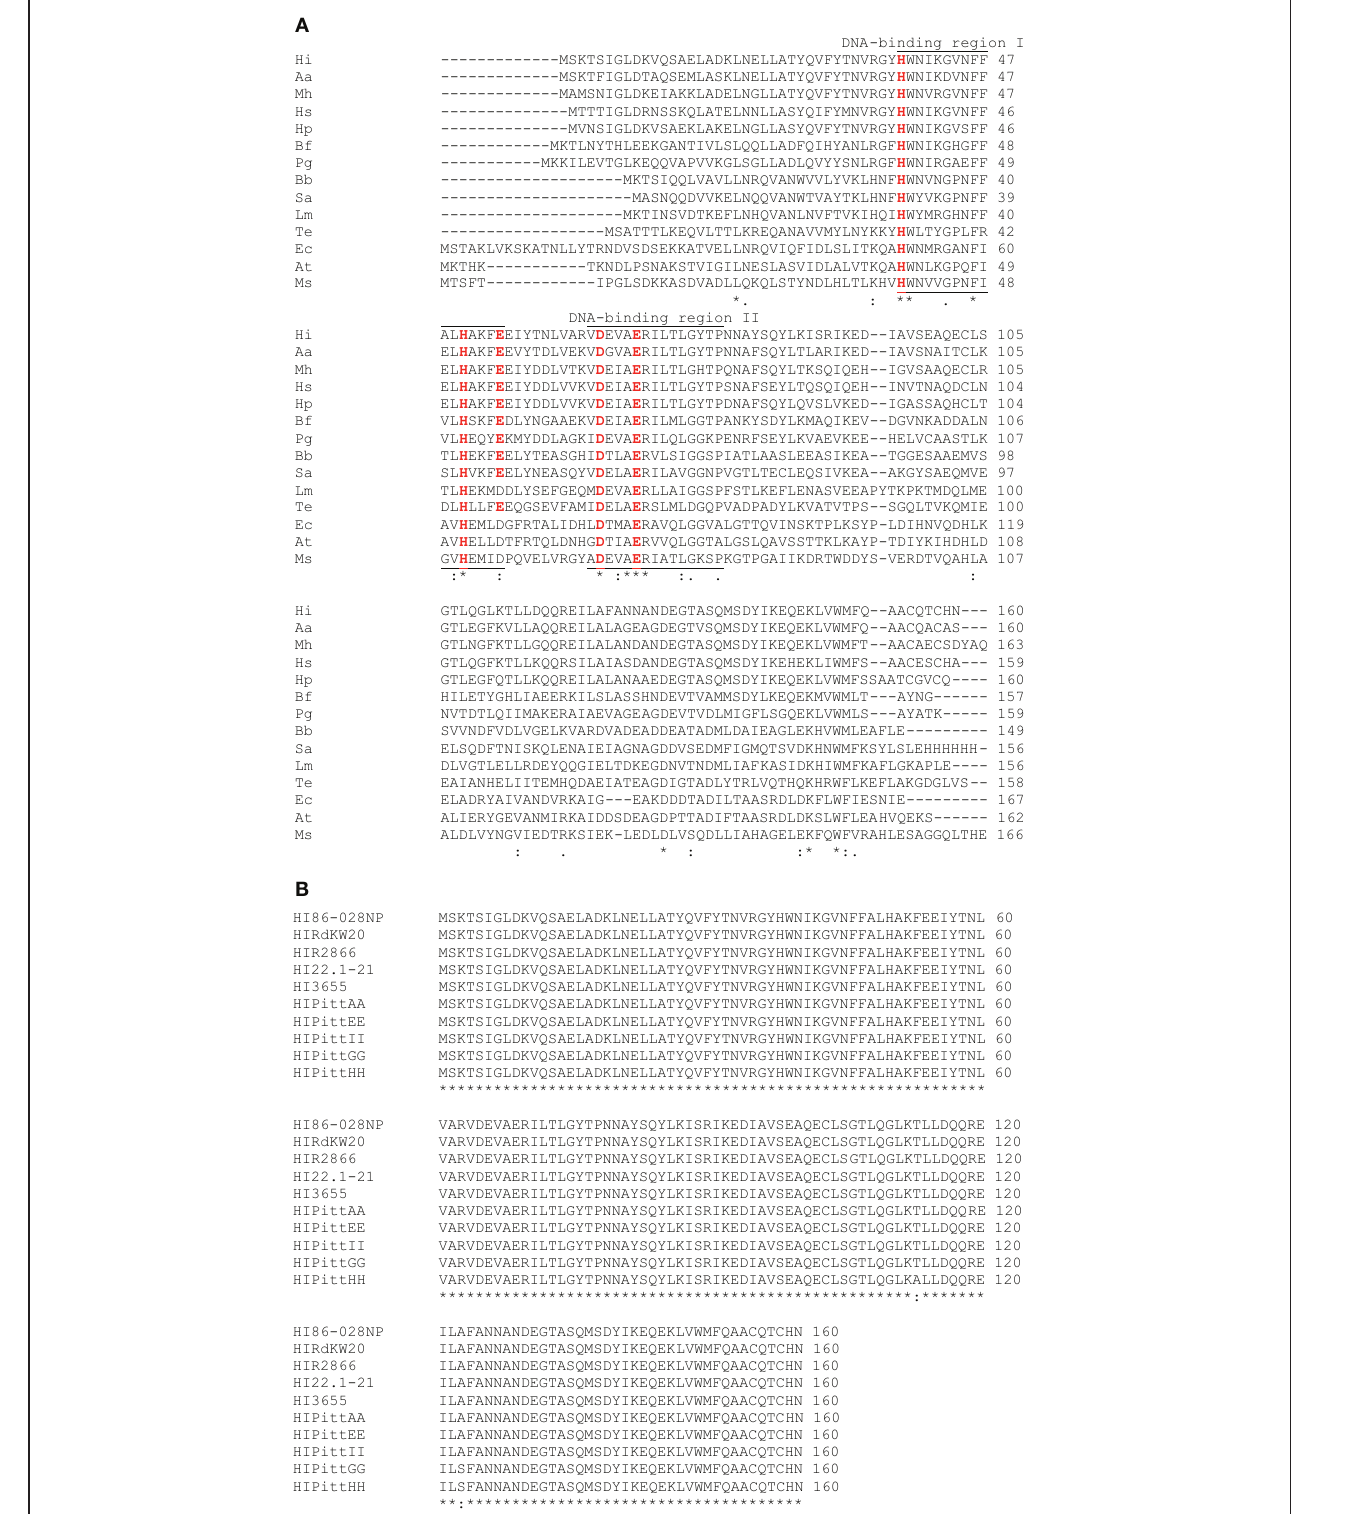
FIGURE 1 | BLAST comparison of NTHI1817. (A) Comparison with dps orthologs from other bacterial species. (B) dps is highly conserved among sequenced H. influenzae strains.